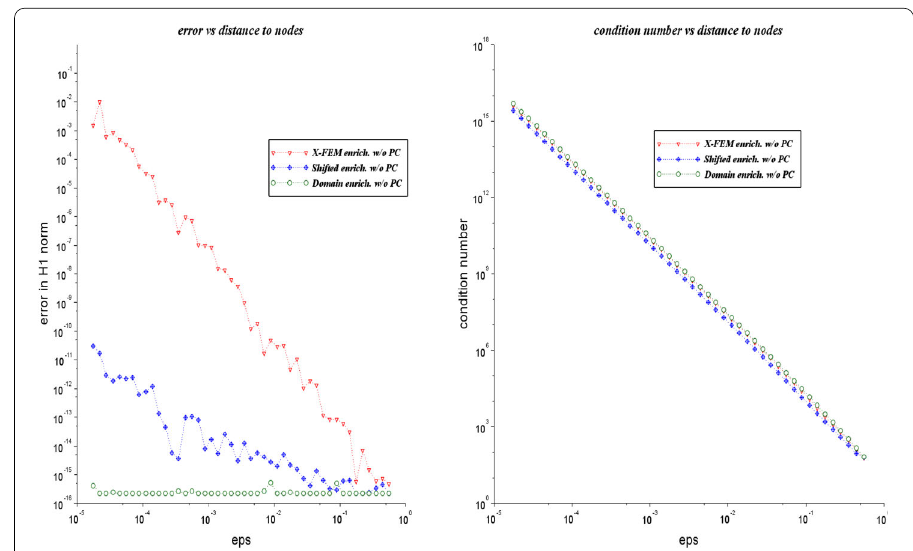
Fig. 18 Asymptotic behavior with Bernstein polynomials. Bernstein polynomials allow emphasizing once more that conditioning and accuracy are separated issues: the condition numbers of all three approximation spaces are almost the same, but there is a great difference in accuracy when “eps” ( ε ) goes to zero